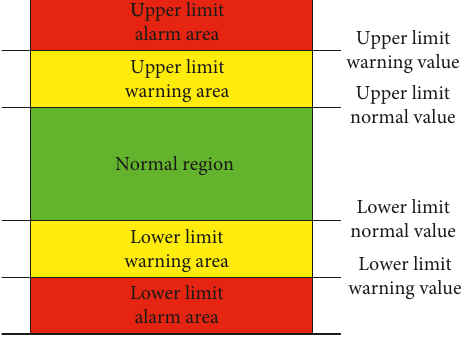
Figure 7: Monitoring warning grading.